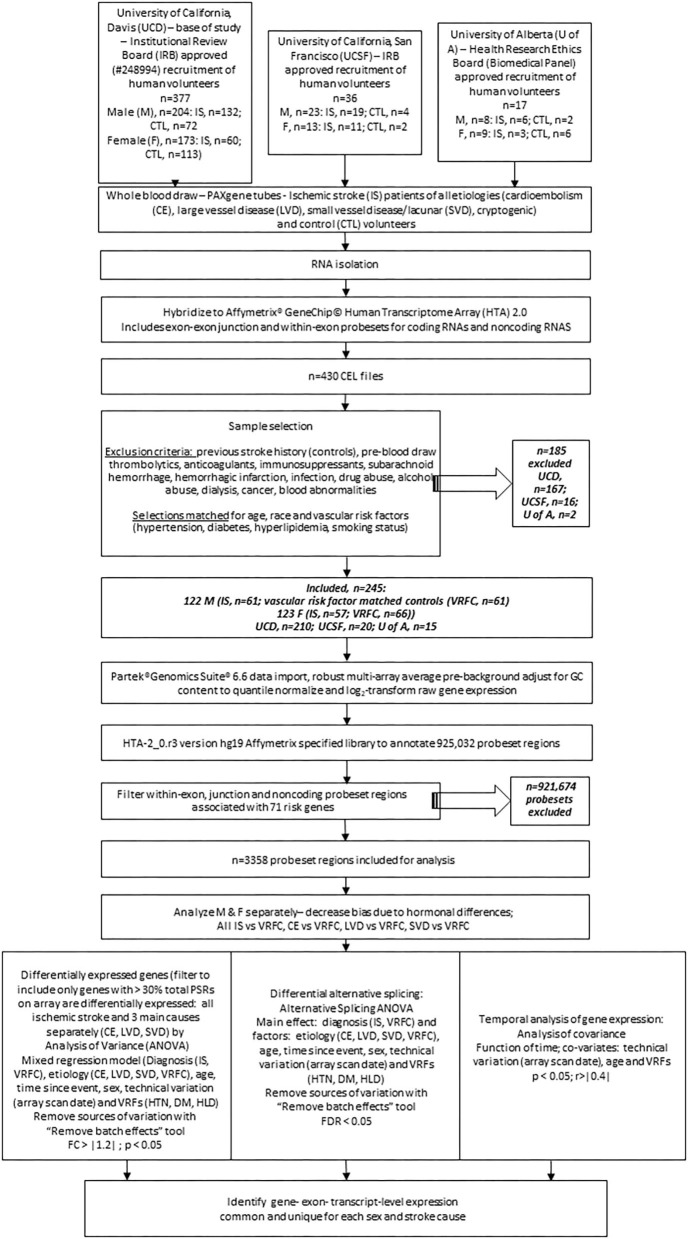
Experimental flowchart showing steps followed for analysis of gene expression in the peripheral blood of human ischemic stroke patients and control subjects recruited at three medical centers. M, male; F, female; IRB, internal review board; UCD, University of California, Davis; UCSF, University of California; San Francisco; U of A, University of Alberta; nc, non-coding; VRF, vascular risk factor; HTN, hypertension; DM, diabetes mellitus; HLD, hyperlipidemia; IS, ischemic stroke; VRFC, vascular risk factor matched control; RMA, robust multi-array average; DEG, differentially expressed gene; PSR, probeset region; CE, cardioembolism; LVD, large vessel disease; SVD, small vessel disease; DAS, differential alternative splicing.